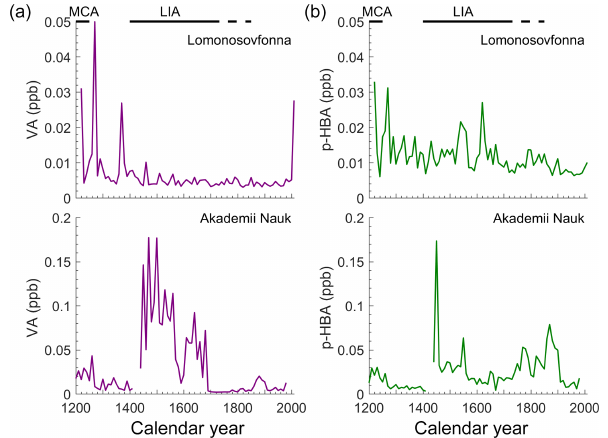
Figure 6. Aromatic acids in the Lomonosovfonna, Svalbard, and Akademii Nauk ice cores. (a) Vanillic acid and (b) p - hydroxybenzoic acid. Violet lines are 10-year bin averages of the Lomonosovfonna ice core. Green lines are the 10-year bin av- erages of the Akademii Nauk ice core measurements (Grieman et al., 2017). The black horizontal lines are the Medieval Climate Anomaly (MCA) and the Little Ice Age (LIA) (Mann et al., 2009). The dashed horizontal line is the extended LIA in the Svalbard re- gion (Divine et al., 2011).